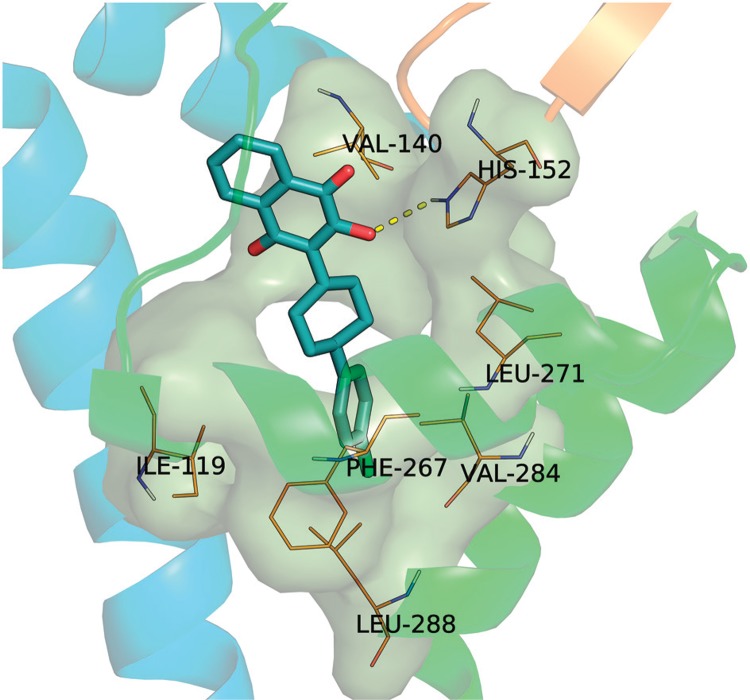
: predicted binding mode for atovaquone in the Qo site of Plasmodium falciparum bc1. Protein residues participating in close contacts (3.0 Å, carbons in salmon) with atovaquone (carbons in white) are show in sticks and labeled. Hydrogen bonding interaction with His152 of the Rieske ISP is shown as a dotted yellow line. The Qo site surface was rendered transparent and coloured green. Elements of secondary structure delineating the Qo site are shown in ribbon diagrams.